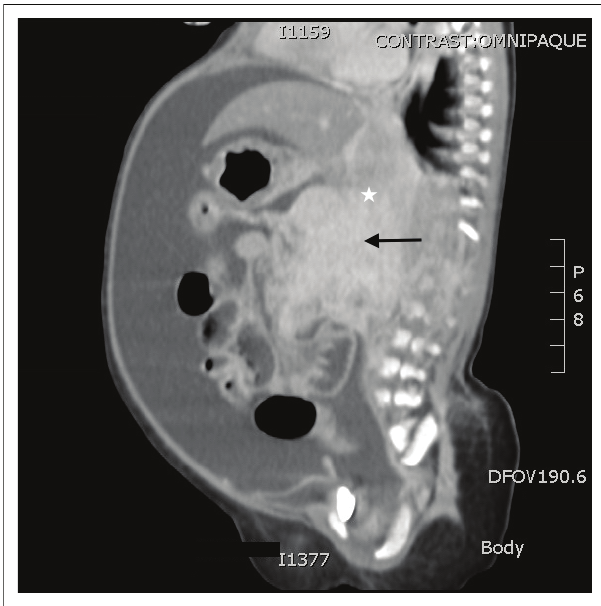
FIGURE 2: Sagittal post-contrast computed tomography image illustrating a bulky, inhomogeneously enhancing mass in the head of the pancreas (black arrow) with ill-defined margins and extension into the porta hepatis (white star).